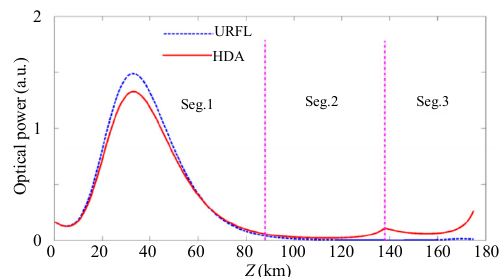
Fig. 8 Rayleigh backscattering trace comparison between URFL and HDA schemes in simulation.